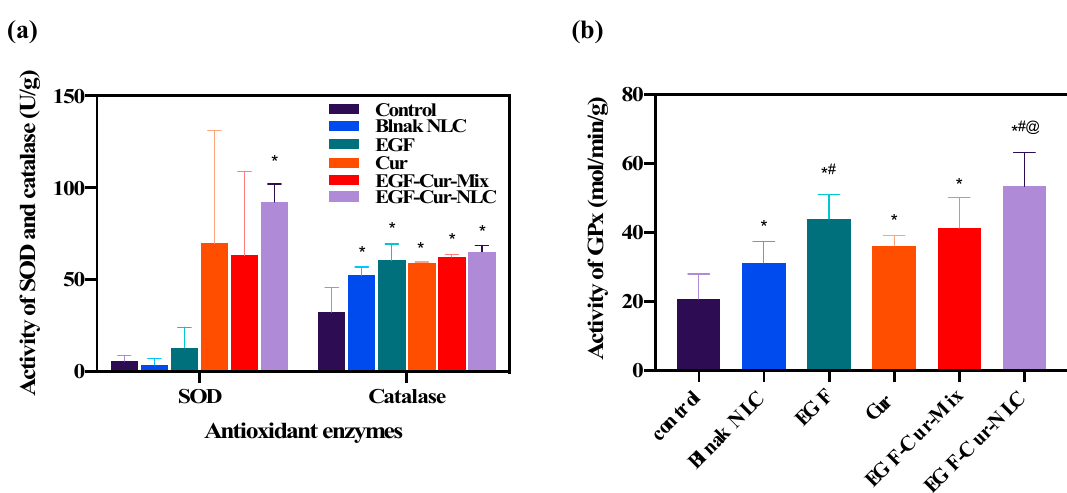
Figure 6. Antioxidant enzymes activity after treatment with the different formulations. ( a ) Superoxide dismutase (SOD), catalase, and ( b ) glutathione peroxidase (GPx) activities in wounded tissues; * p < 0.05 compared to the control, # p < 0.05 compared to blank-NLC, @ p < 0.05 compared to EGF–Cur- Mix.